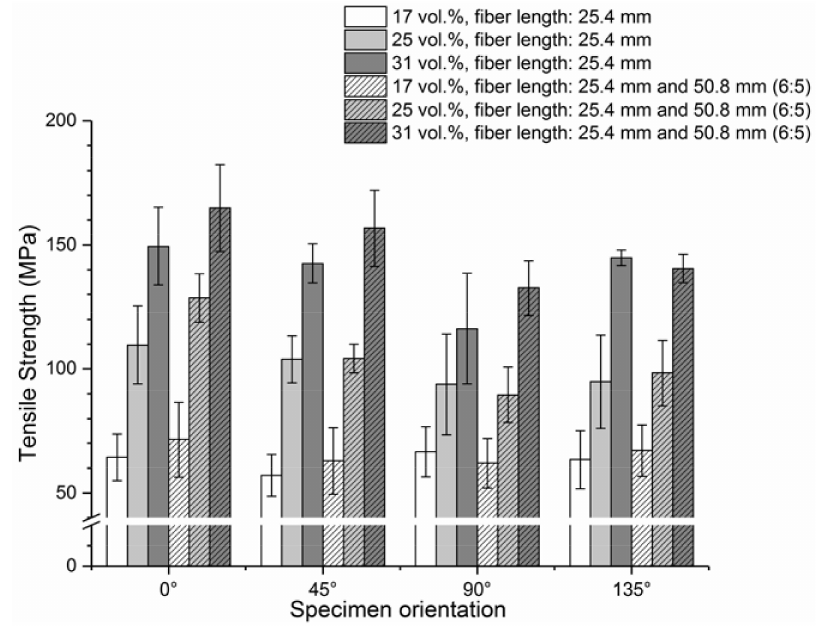
Figure 5. Tensile strength of different SMC materials in different directions with respect to the movement of the conveyor